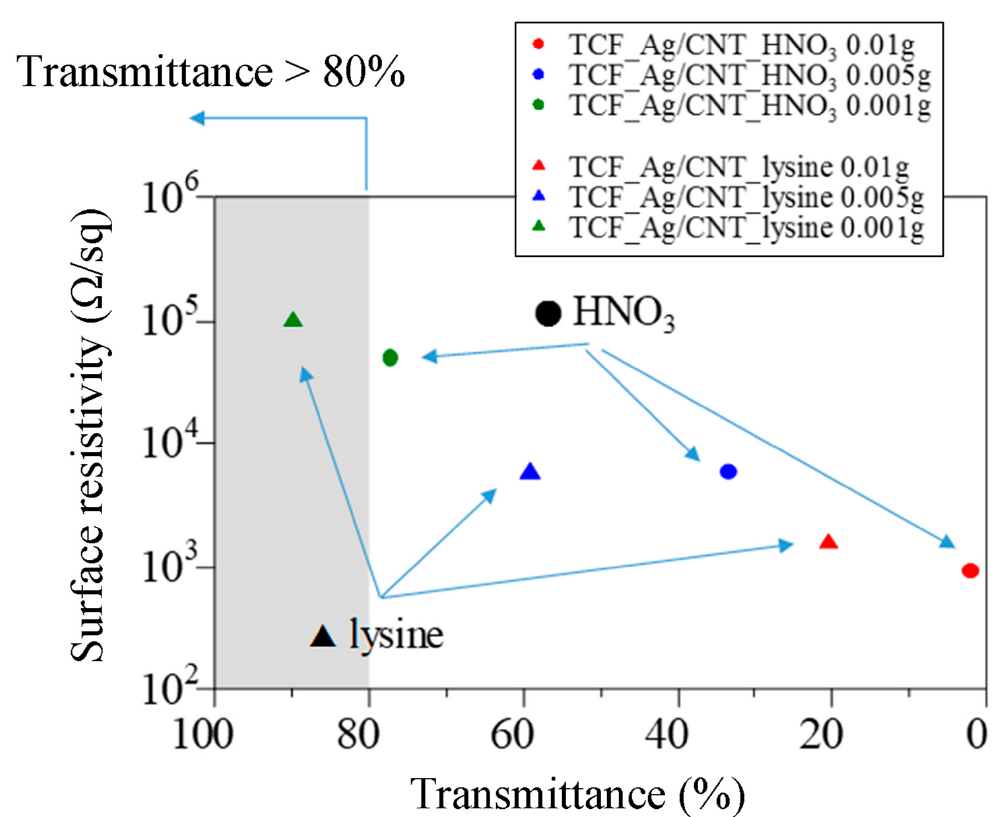
Figure 10. Relationship between the surface resistivity of AgNP/MWCNT films and the transmit ‐ tance.